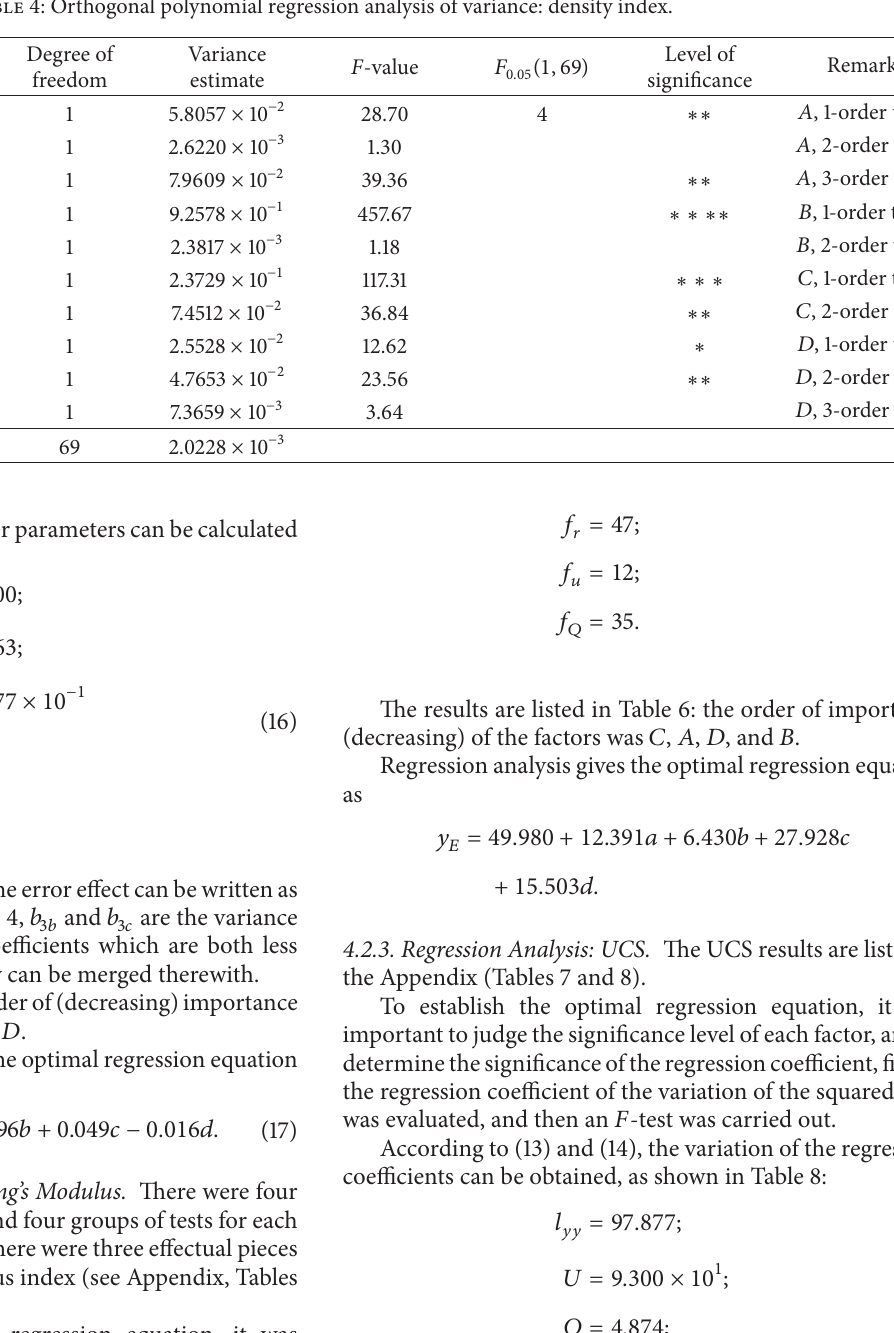
Table 4: Orthogonal polynomial regression analysis of variance: density